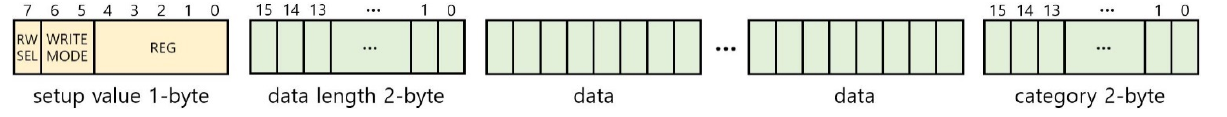
Figure 4. Protocol for learning and recognition in detail.